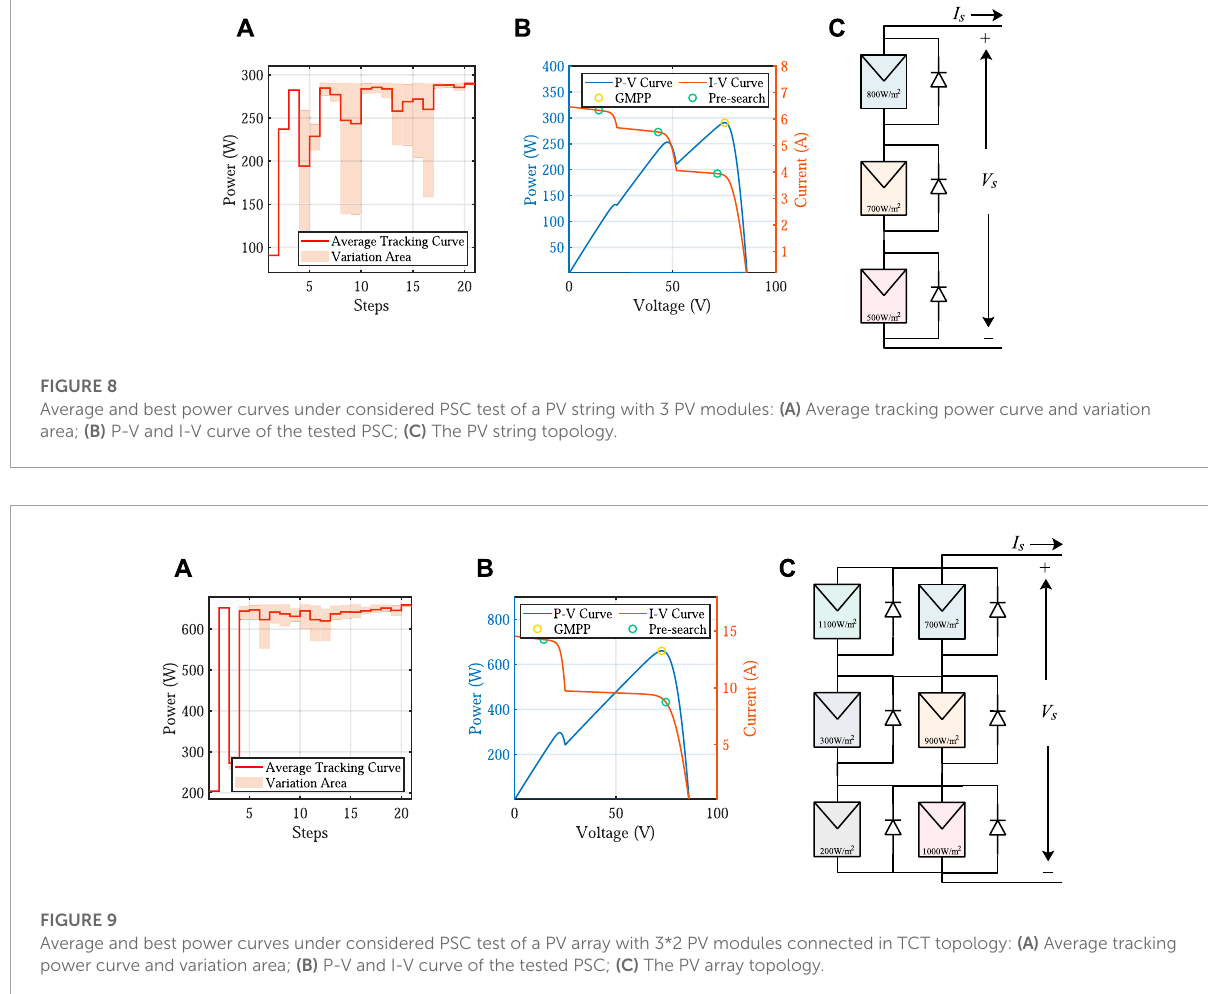
considered as a controllable voltage source. Different PV strings (monocrystalline, polycrystalline, and thin-film) with 3, 5, 7 series-connected modules are used in the simulation. Table